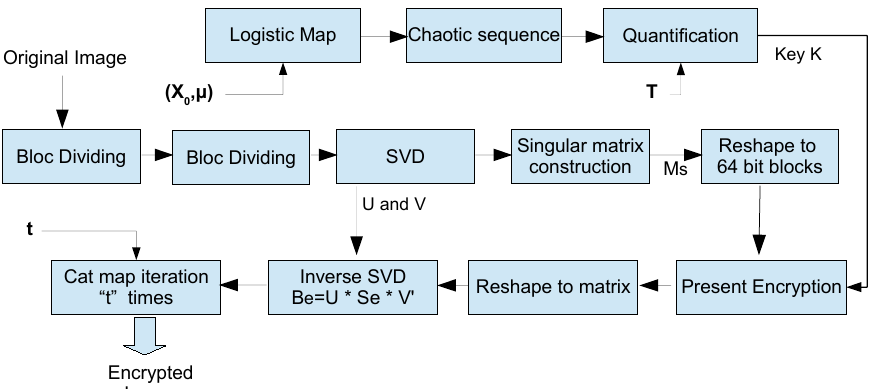
Figure 7. Flowchart of the encryption procedure employed.